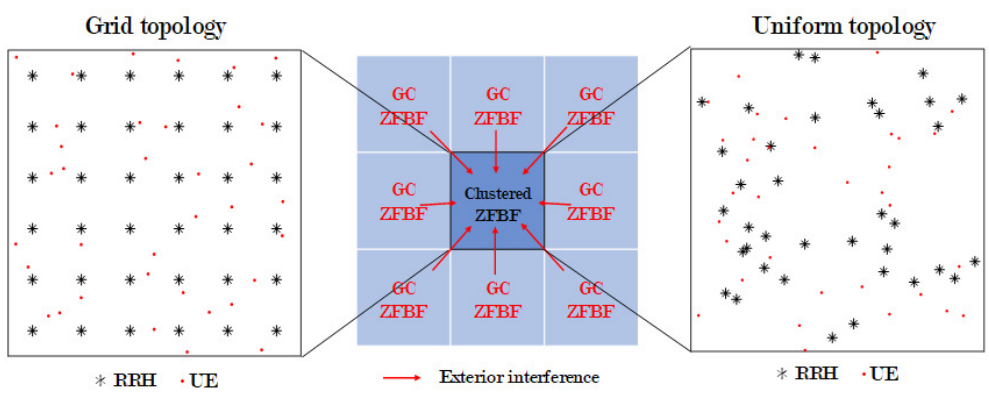
Figure 1. Concept of exterior interference from eight baseband units (BBU) environment with globally coordinated zero-forcing beamforming (ZFBF) in two